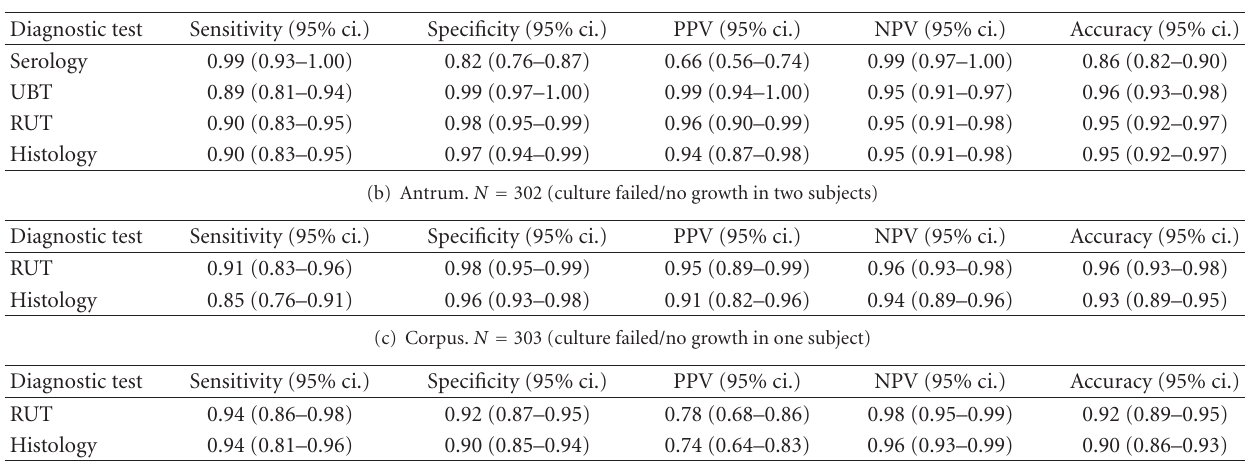
Table 3: Performance of di ff erent diagnostic tests for H. pylori infection. Each method is tested against culture as gold standard. RUT: